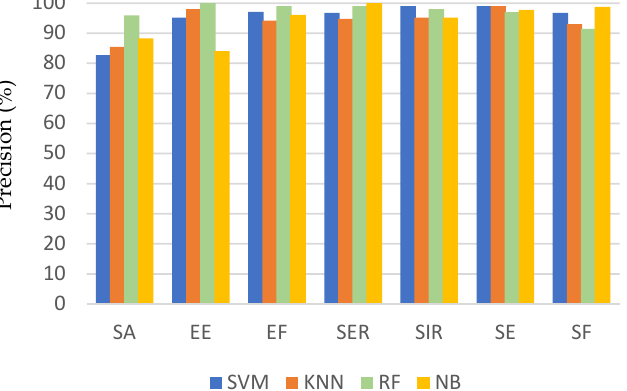
Figure 7. Precision for each activity using different classification algorithms.